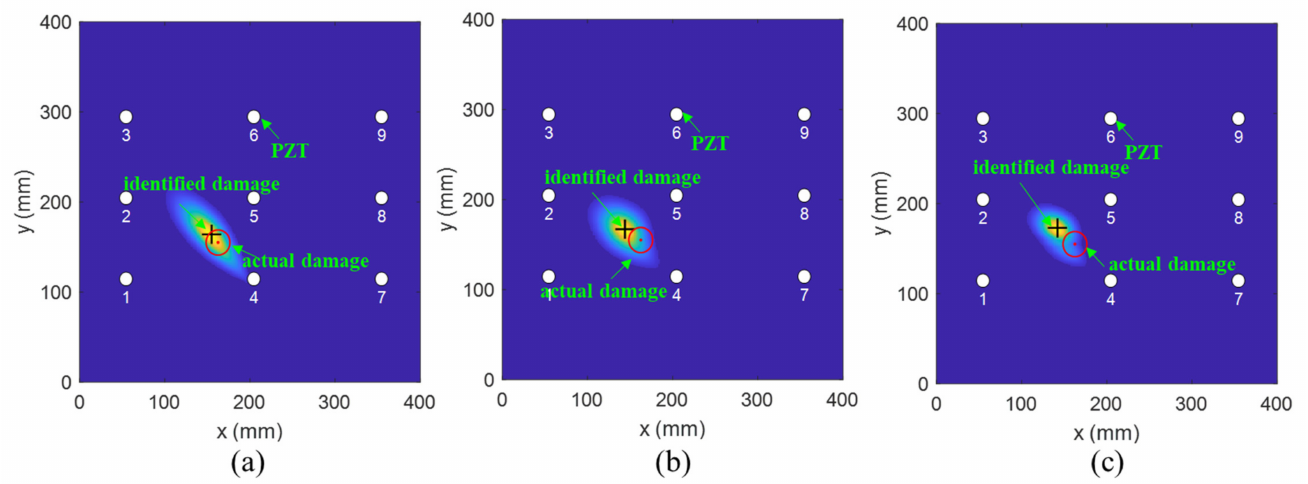
Figure 20. The imaging results of one virtual damage at location (238 mm, 245 mm) obtained by ( a ) the modified PDI method, ( b ) the fused PDI method, and ( c ) the conventional PDI method.